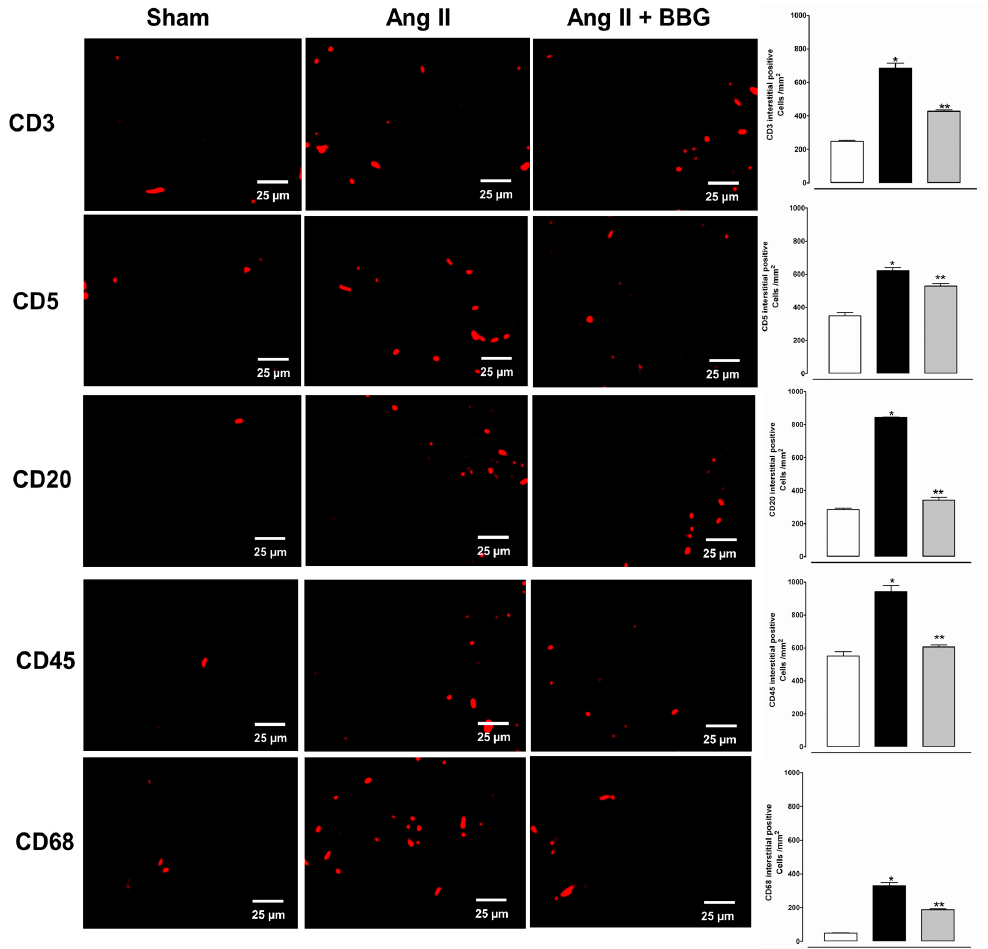
Figure 5. Infiltrating T cells (CD3, CD5), B cells (CD 20) and macrophages [CD68], are increased in the renal cortical interstitium of the angiotensin-infused rats (Ang II group n = 7), and reduced by the administration of BBG (Ang II + BBG n = 7). CD45 antigen is a leukocyte common antigen predominantly expressed in lymphocytes. White bars ( (cid:3) ) Sham; Black bars ( (cid:4) ) AngII; and grey bars ( (cid:4) ) Ang II + BBG. * p < 0.001 vs. sham, ** p < 0.05 vs. Ang II. Ang II = angiotensin II; BBG = brilliant blue